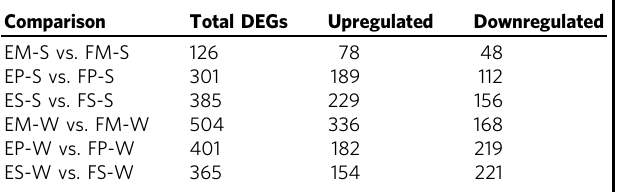
Table 2 The number of signi fi cantly identi fi ed DEGs in the metacarpal (M), perirenal (P), and prescapular (S) adipose tissues of Finnish (F) and Even (E) reindeer that were compared separately for spring (-S) and winter (-W)